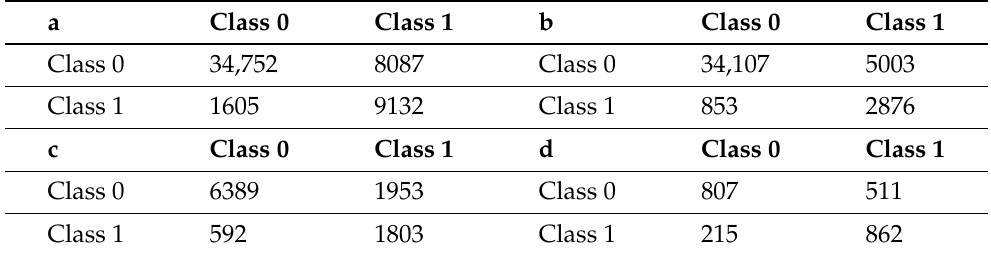
Table 5. Confusion Matrix for each Stage in CNN. (a) Stage 0-Normal, Mild and Severe, Moderate and PDR: Accuracy 81.9%; (b) Stage 1-Normal and Mild: Accuracy 86.3%; (c) Stage 2-Moderate, Severe